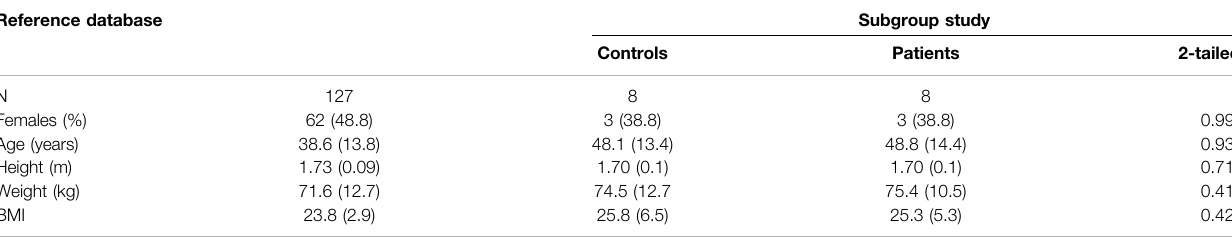
TABLE 1 | Participant characteristics (mean and SD).